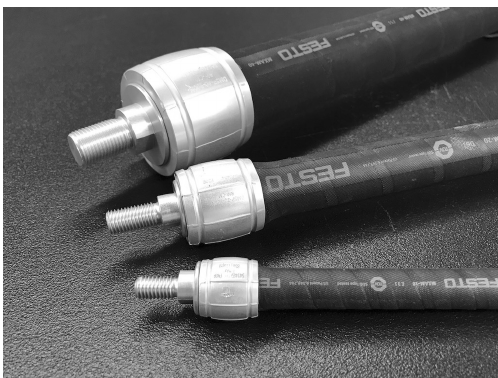
Figure 1. Different Festo pneumatic muscle actuators (PMAs). The depicted connector form is called DMSP . See the data sheet [5] for further